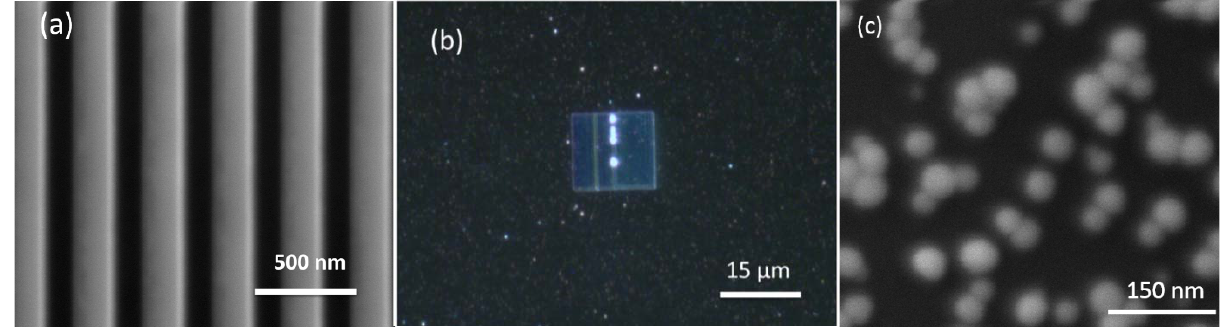
Figure 1. ( a ) SEM image of the fabricated ITO grating structure after focused ion beam (FIB) patterning; ( b ) optical image of the Ag NP self-assembled grating; and ( c ) SEM image of the Ag